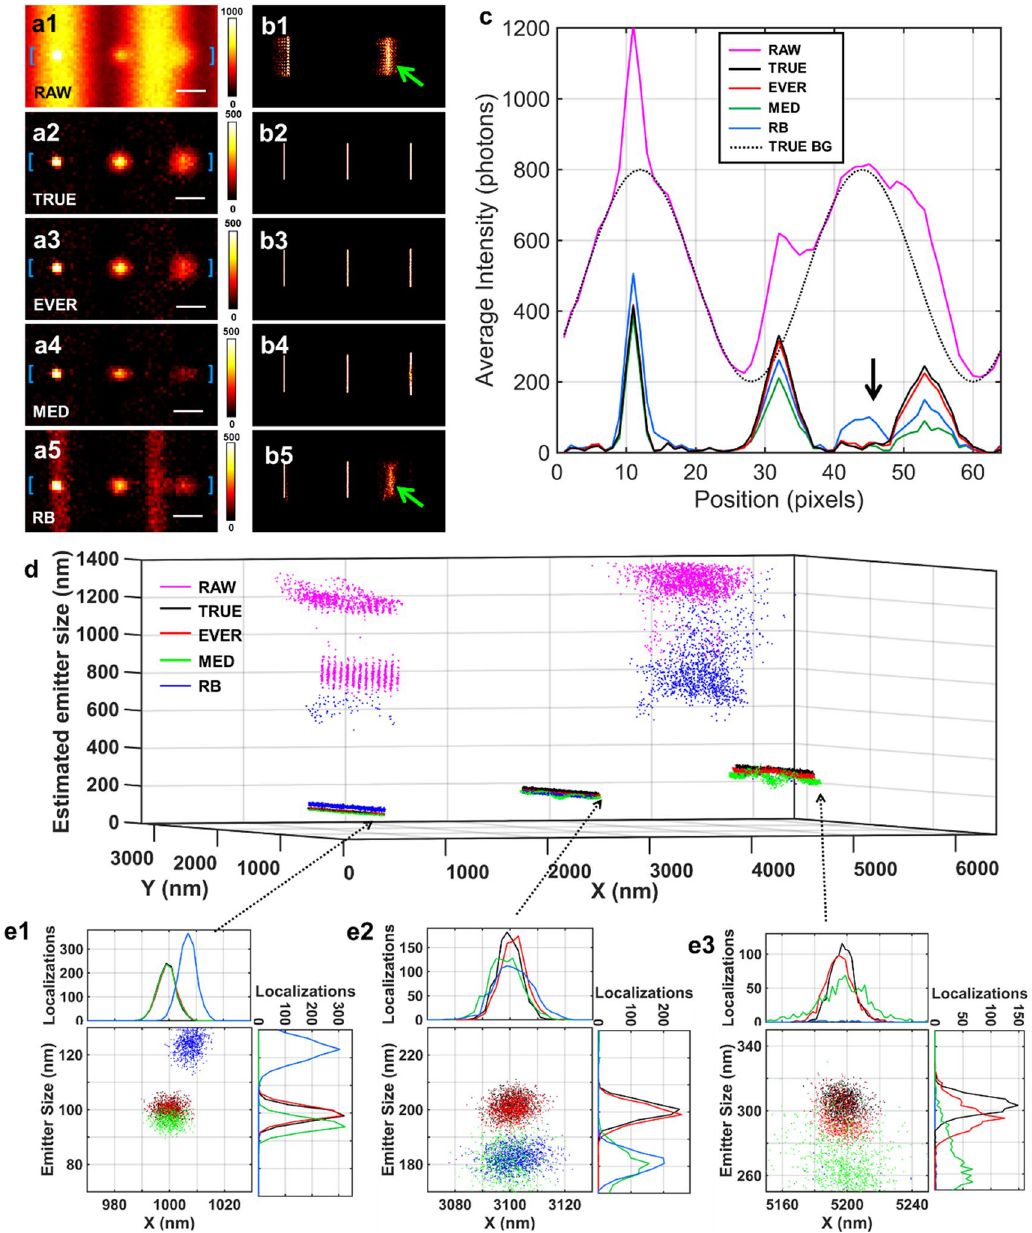
Figure 3. The comparison of different emitter recovery approaches using simulated dataset with various emitter size, emitter intensity and heterogeneous background. ( a ) The raw image ( a1 ), the recovered emitters from the ground truth (TRUE) ( a2 ), and using EVER ( a3 ), MED ( a4 ) and RB (a5). ( b ) The corresponding reconstructed super-resolution images using ThunderSTORM without additional processing ( b1 ) and after emitter recovery using the ground truth ( b2 ), EVER ( b3 ), MED ( b4 ) and RB ( b5 ). Green arrows indicate the image artifact. ( c ) The corresponding intensity profiles (solid lines) from the regions between the blue bracket in ( a1 – a5 ) and the black dashed line (TRUE-BG) represents the profile from the ground-truth background. The black arrow indicates the erroneously recovered emitter signals by RB coming from the residual background. ( d ) The scatter plot of the localized emitters from the raw image without any processing (magenta) and with emitter recovery by the ground truth (black), EVER (red), MED (green) and RB (blue). Emitter localization was performed by ThunderSTORM. ( e1–e3 ) The zoomed distribution of localized emitters in ( c